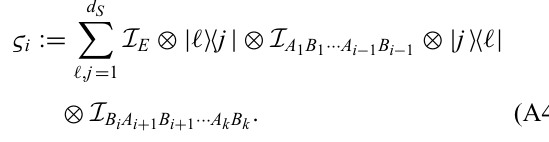
FIG. 9. The Choi-state representation of a k -step process tensor , denoted ϒ k :1 , can be obtained by swapping out the sys- tem, S i with half a maximally entangled state, ψ A i . The final state is an unnormalized many-body state acting on a -dimensional d 2 k + 1 S